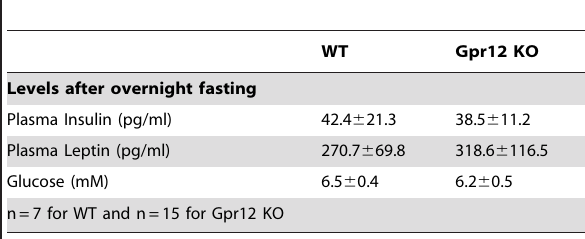
Table 4. Blood chemistry of wild type (WT) and Gpr12 deficient (Gpr12 KO) mutant mice – Australian study.